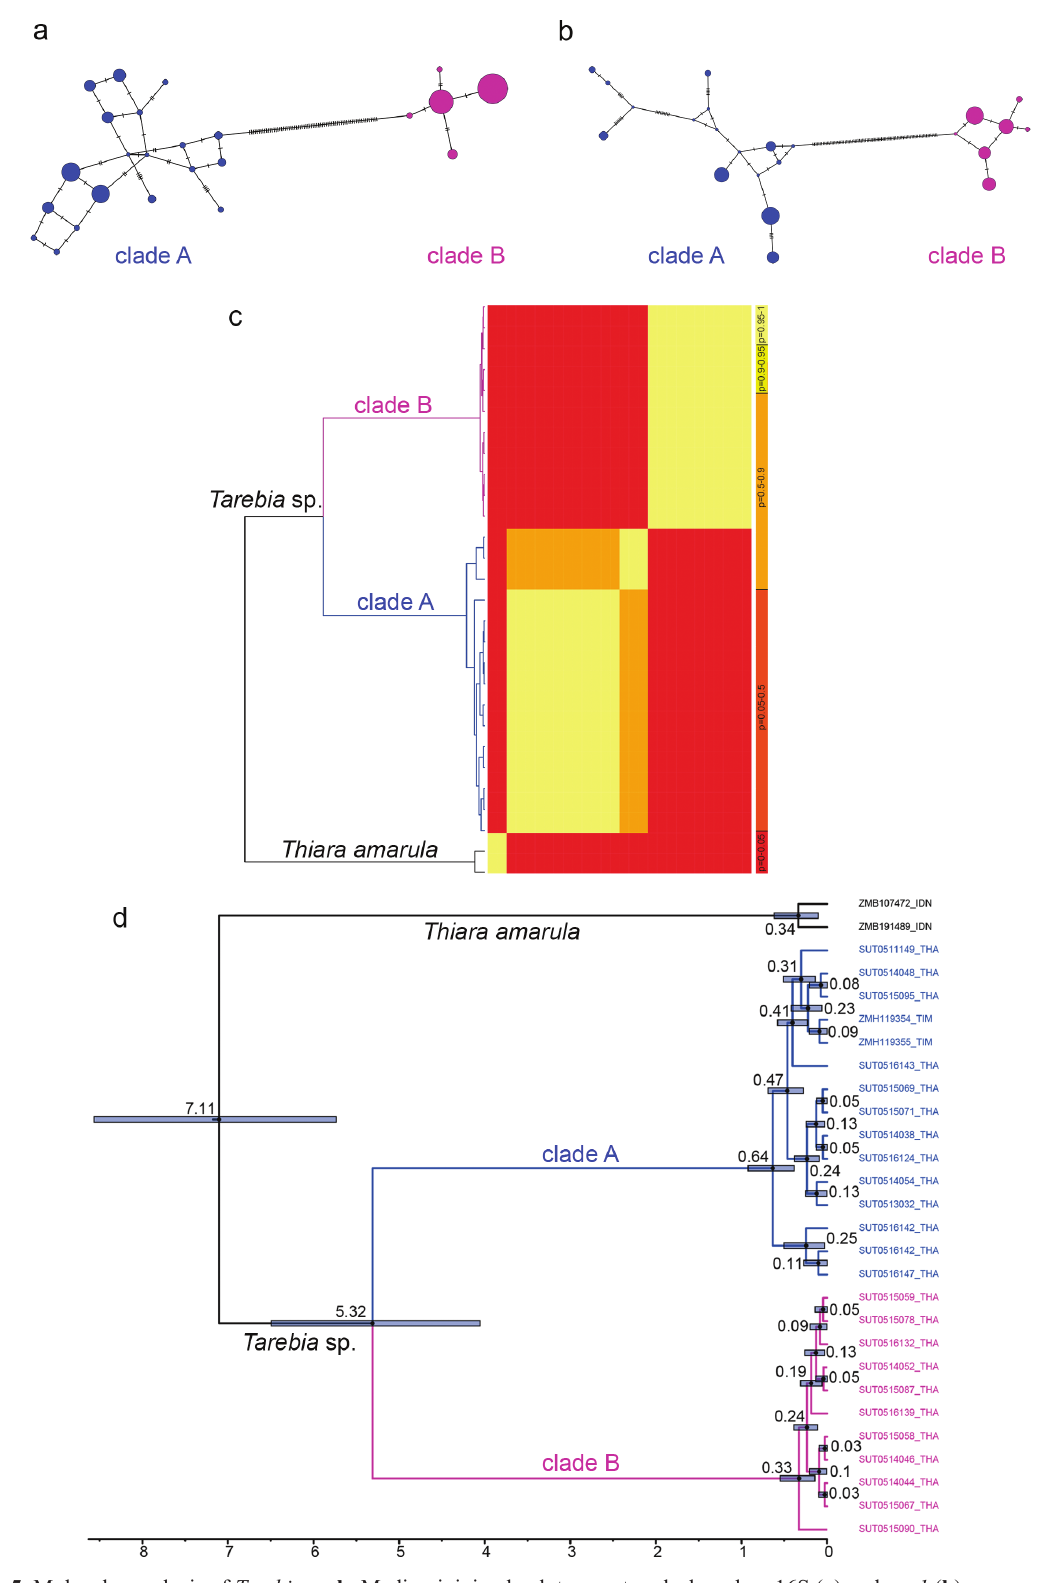
Figure 5. Molecular analysis of Tarebia . a–b . Median-joining haplotype networks based on 16S ( a ) and cox1 ( b ) sequence data of Tarebia granifera (Lamarck, 1816). The size of each circle represents the frequency of a haplotype and the colour refers to main mitochondrial clades obtained from the phylogenetic analyses (Fig. 4; blue: clade A, magenta: clade B). Tick marks between circles represent evolutionary steps. c . Results of the bGMYC analysis. Colouration of the matrix cells represents pairwise probabilities of conspecificity. d . Dated molecular tree (only unique haplotypes were included). Numbers at the nodes are node ages in Ma, bars represent 95% highest posterior probabilitiy